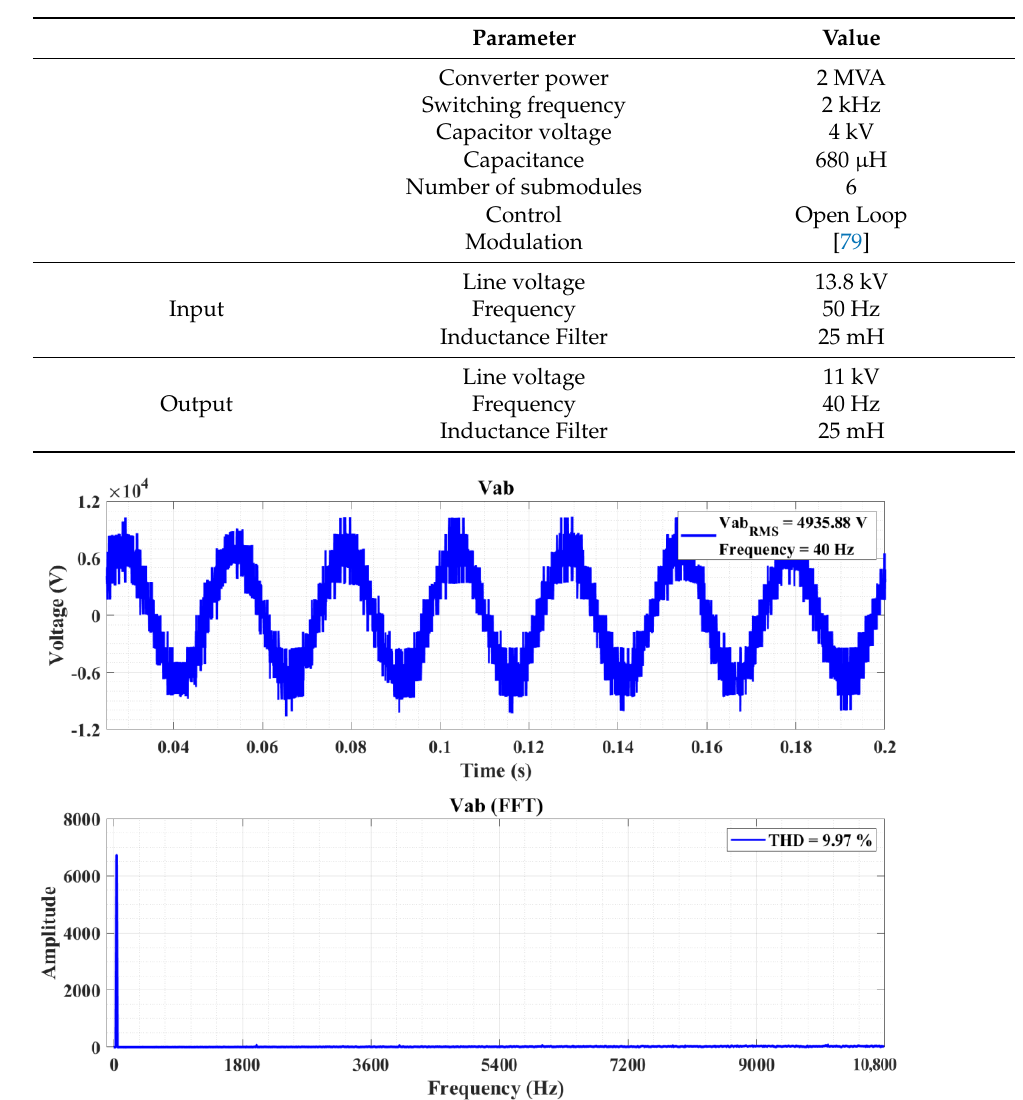
Figure 20. Line voltage and M3C harmonic